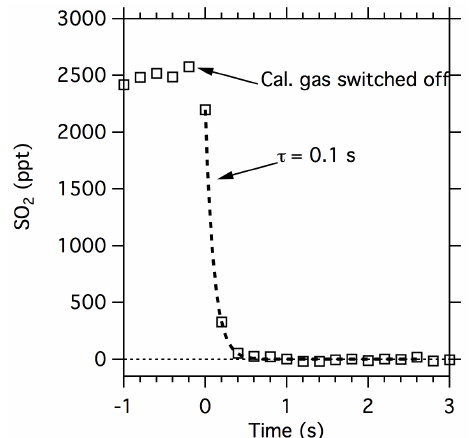
Figure 8. Example of the instrument time response following the removal of calibration gas from the instrument sample line. The dashed line is an exponential decay with a time constant of